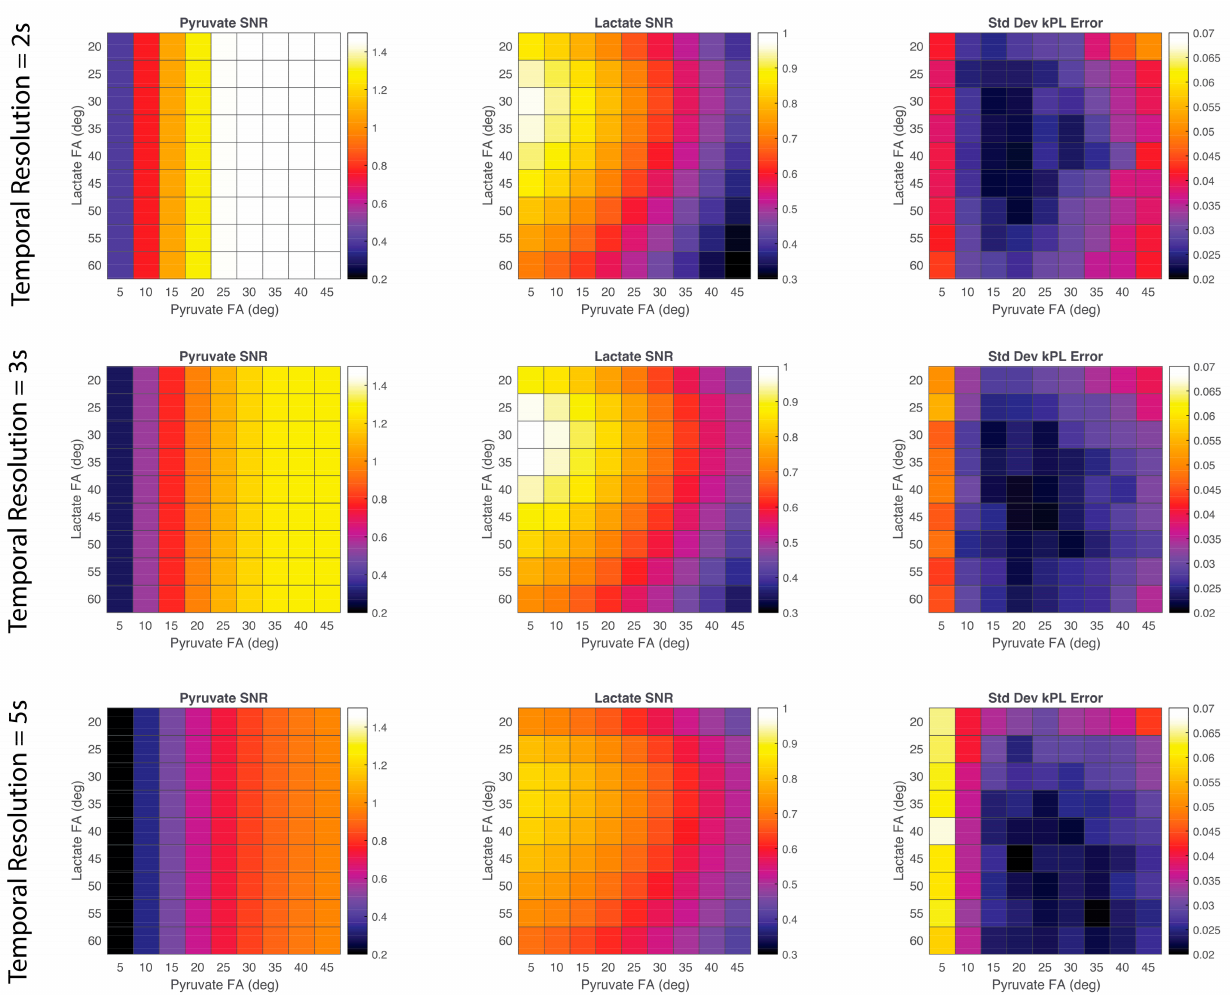
Figure 4. Pyruvate and lactate SNR and k PL fitting error of simulated EPI signal for various temporal resolutions and pyruvate and lactate flip angles (FAs). The simulation used the following parameters: k PL = 0.05 1/s; T 1,pyruvate = 20 s; and T 1,lactate = 30